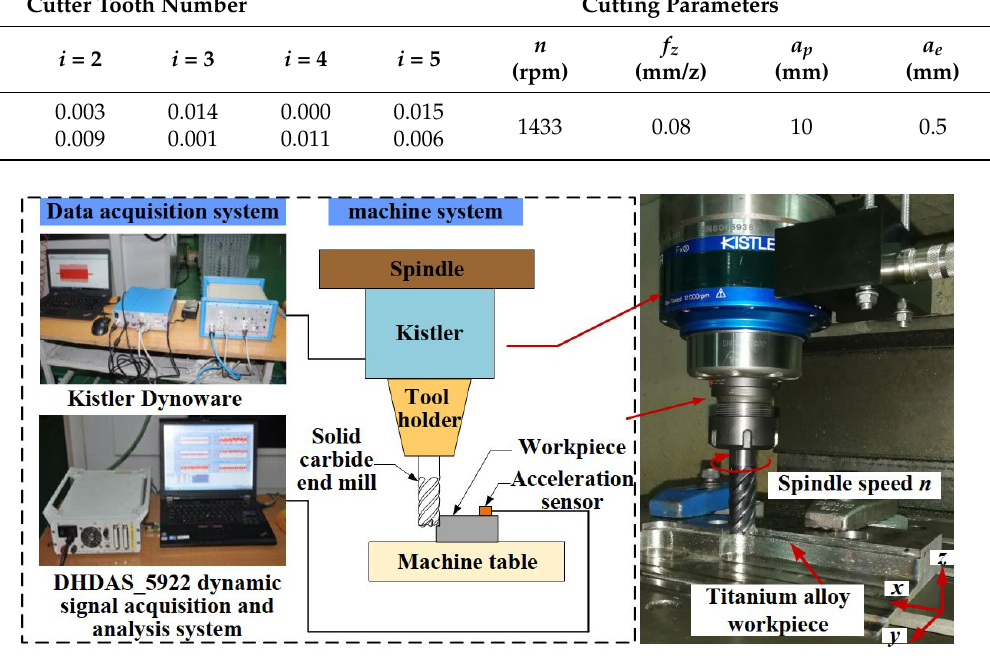
Figure 5. Experiment on milling vibration and cutting force.